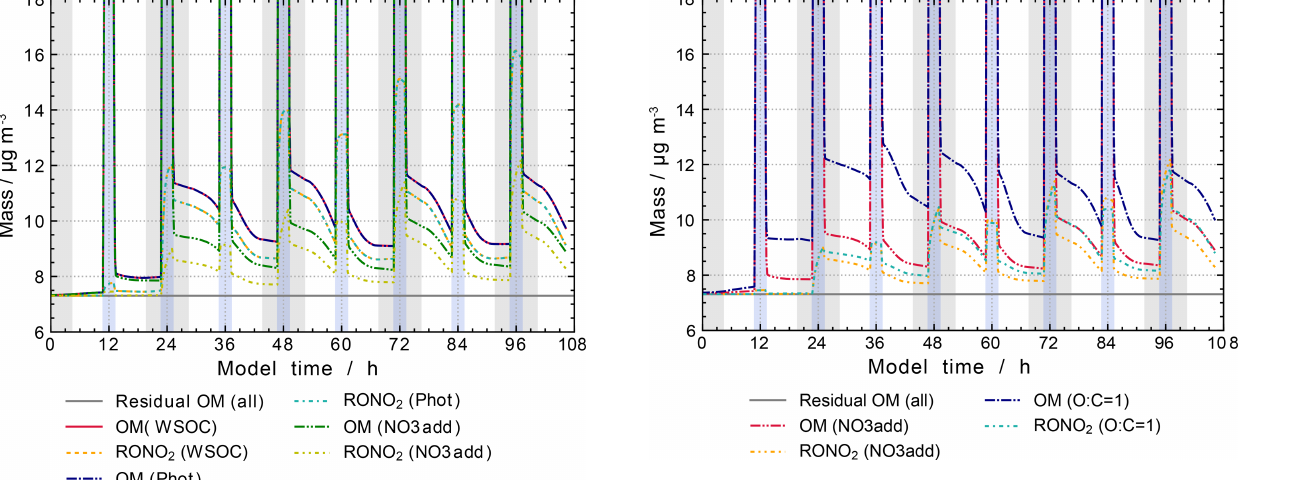
Figure 15. Processing of the organic mass fraction in the sensitivity runs investigating the influence of the phase transfer of oxygenated organic compounds on aqueous-phase chemistry and composition. The same conditions as in the scenario “NO3add” were used but with HLCs set to 1 × 10 9 Matm − 1 for species with an O : C ratio greater than or equal to 1. Cloud passages are shaded blue and night- time periods are shaded grey. Scenario names used in the legend are explained in Appendix